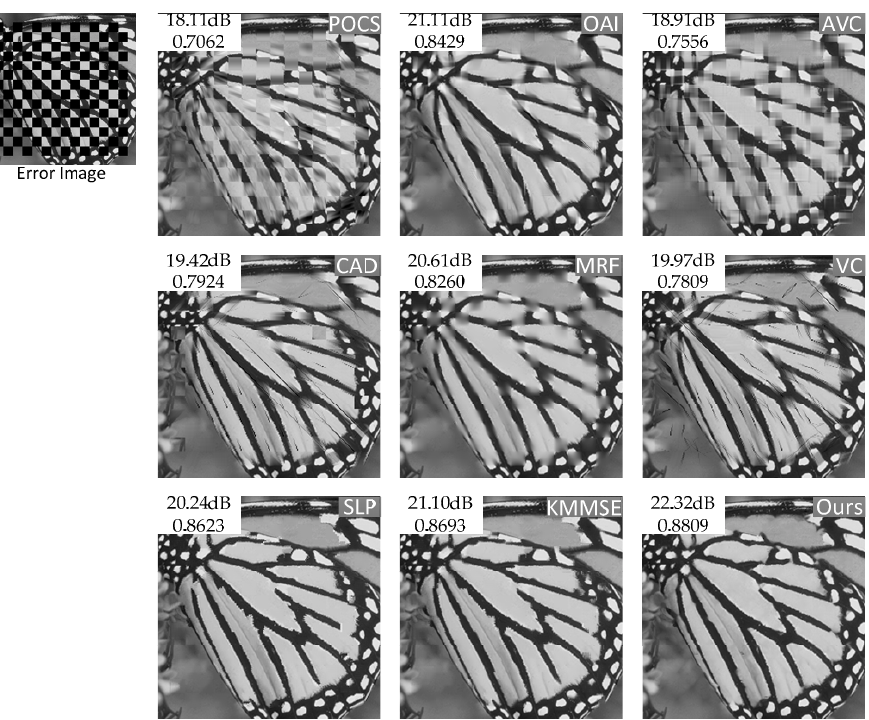
Figure 19. Subjective comparison of different EC algorithms on the Barbara image with 16 × 16 isolate block loss. The corresponding PSNR and SSIM values are also shown in the upper left corner.